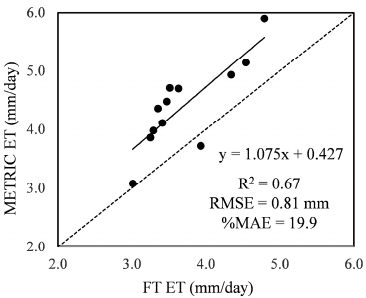
site in Rondônia. Image date: 13 July 2002.